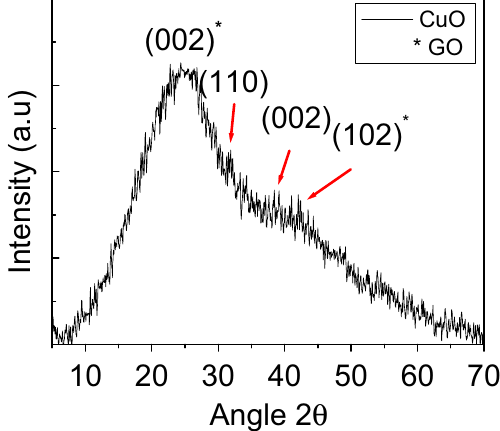
Figure 3. XRD spectrum of CuO NS synthesized via green synthesis using Rhazya stricta aqueous extract showing major diffraction peaks. XRD spectrum was produced by OriginPro 2018 (64bit).